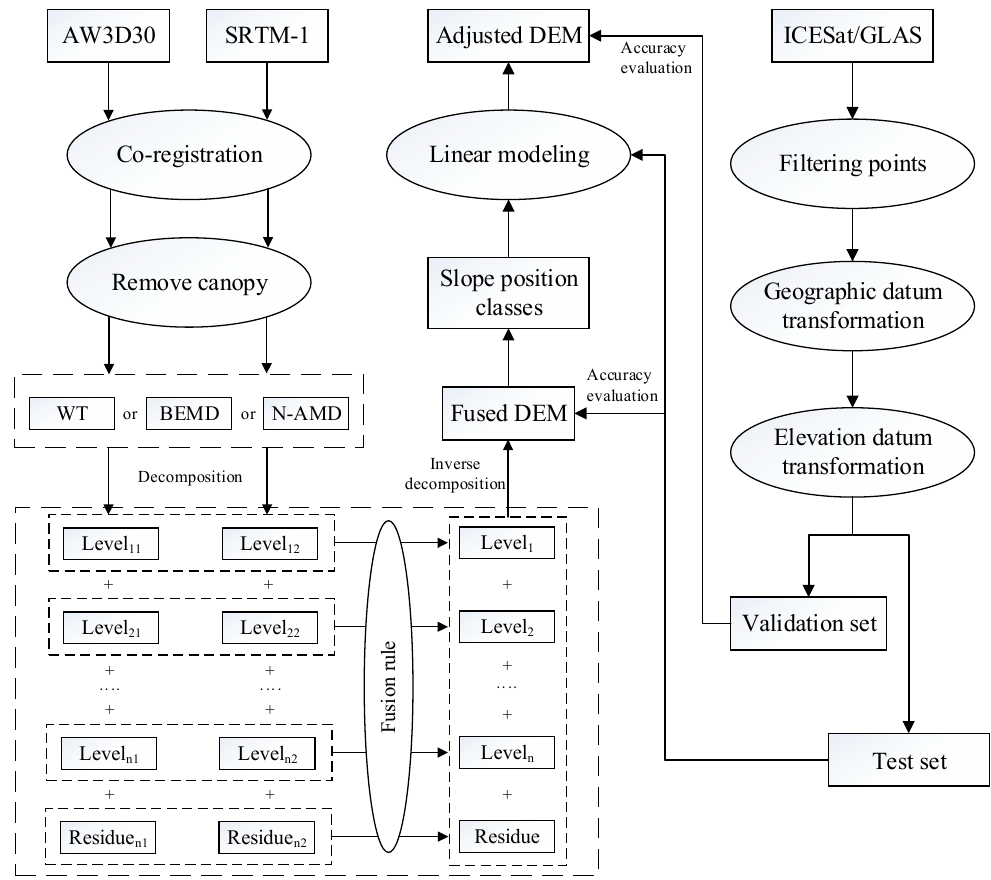
Figure 3. Schematic flowchart of the multi-scale fusion of the SRTM-1 and AW3D30.